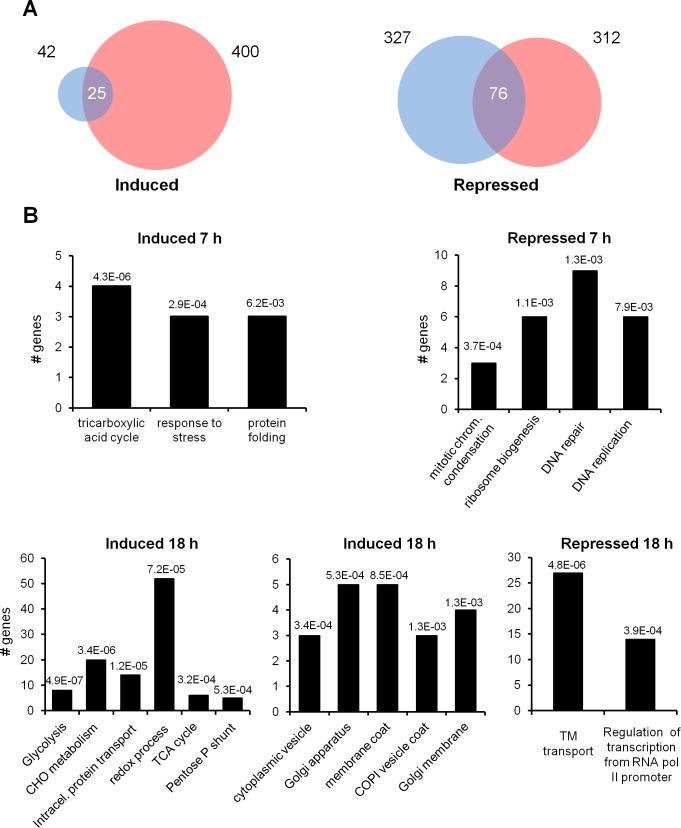
Gene expression changes by RNAseq in titan-like cells obtained in vitro.Transcriptomic profiling of the transition to titan-like cells. A) Number of genes induced or repressed after 7 h (blue) or 18 h (red). The number of genes whose expression is modified at both times is denoted at the intersection of the circles. Scale is only approximated. B) Gene Ontology analysis of genes induced or repressed at 7 h (upper panel) or 18 h (lower panel). All classifications correspond to “biological function” terms, except the central graph in the lower panel, which correspond to “cellular components”. Numbers in the histograms denote the p-value for each assignment. See Materials and Methods for details.